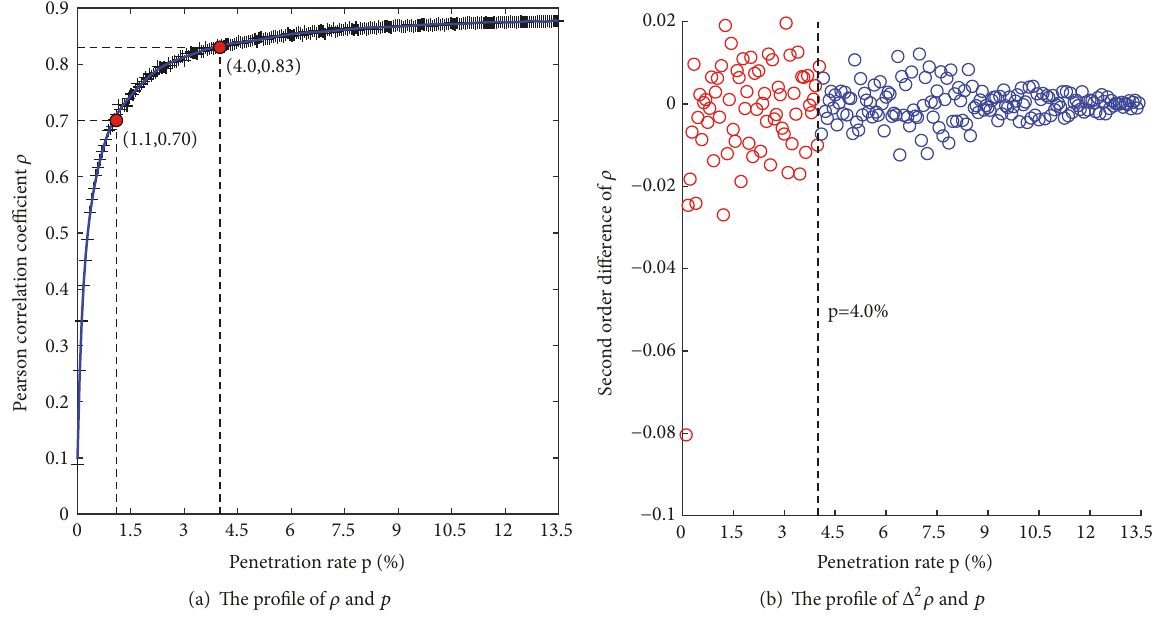
Figure 12: The relationship between the Pearson correlation coefficient and the penetration rate.